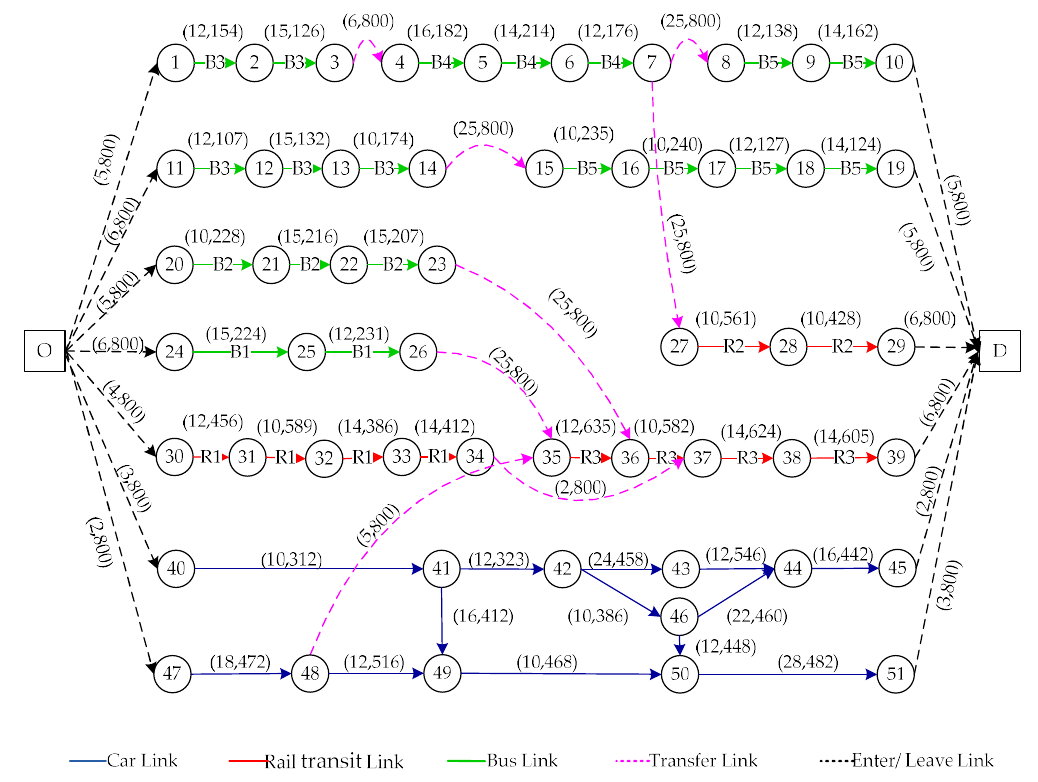
Figure 16. The generalized cots and capacity of each link in the super network topology.